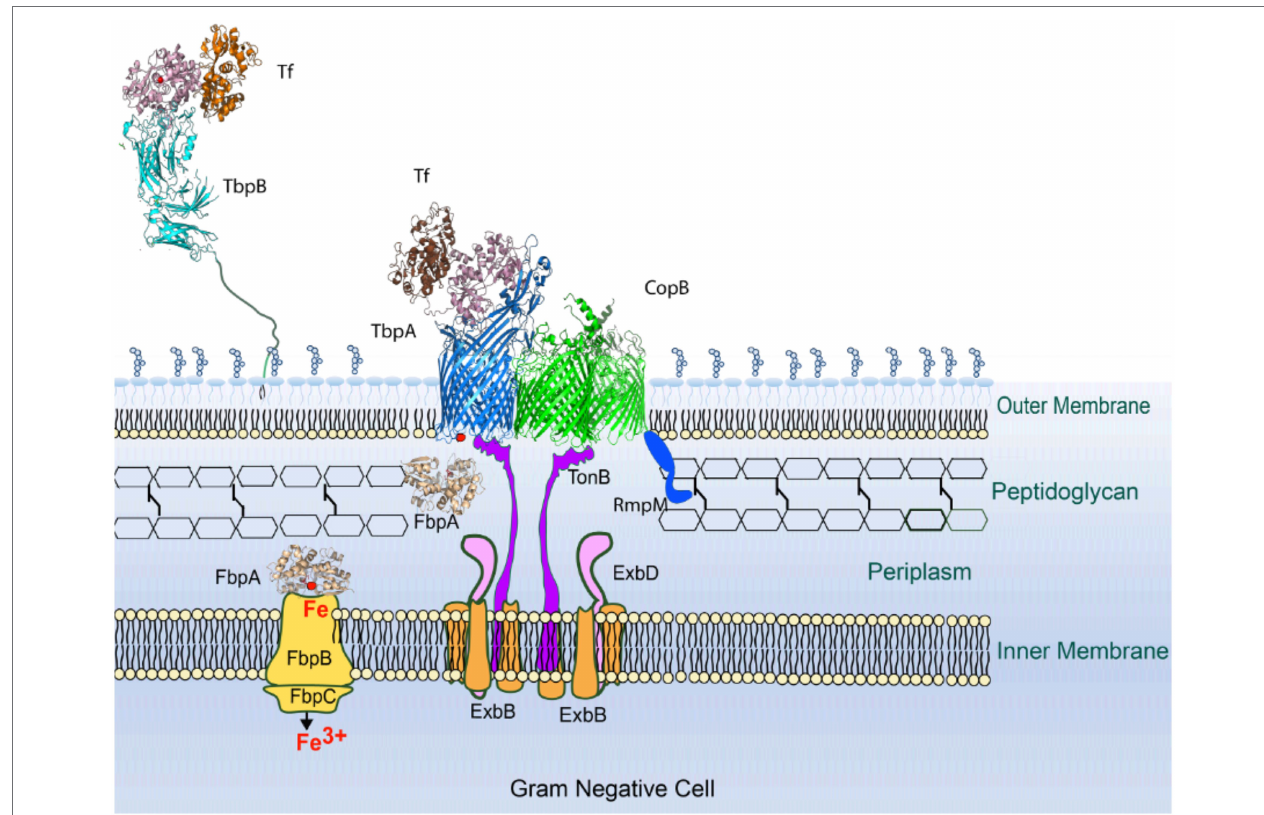
FIGURE 5 | Model for TonB-mediated interactions in M. catarrhalis . In either newly formed or pre-existing gaps in the peptidoglycan layer, CopB is the dominant TonB-dependent transport (TBDT) present due to its high level of expression. Ultimately the TonB complex and TBDTs will cluster around the gap in the peptidoglycan layer resulting in more efficient transport. It is likely that an RmpM homologue will contribute to formation of the “clustered” TBDTs and indirectly influence TonB-dependent